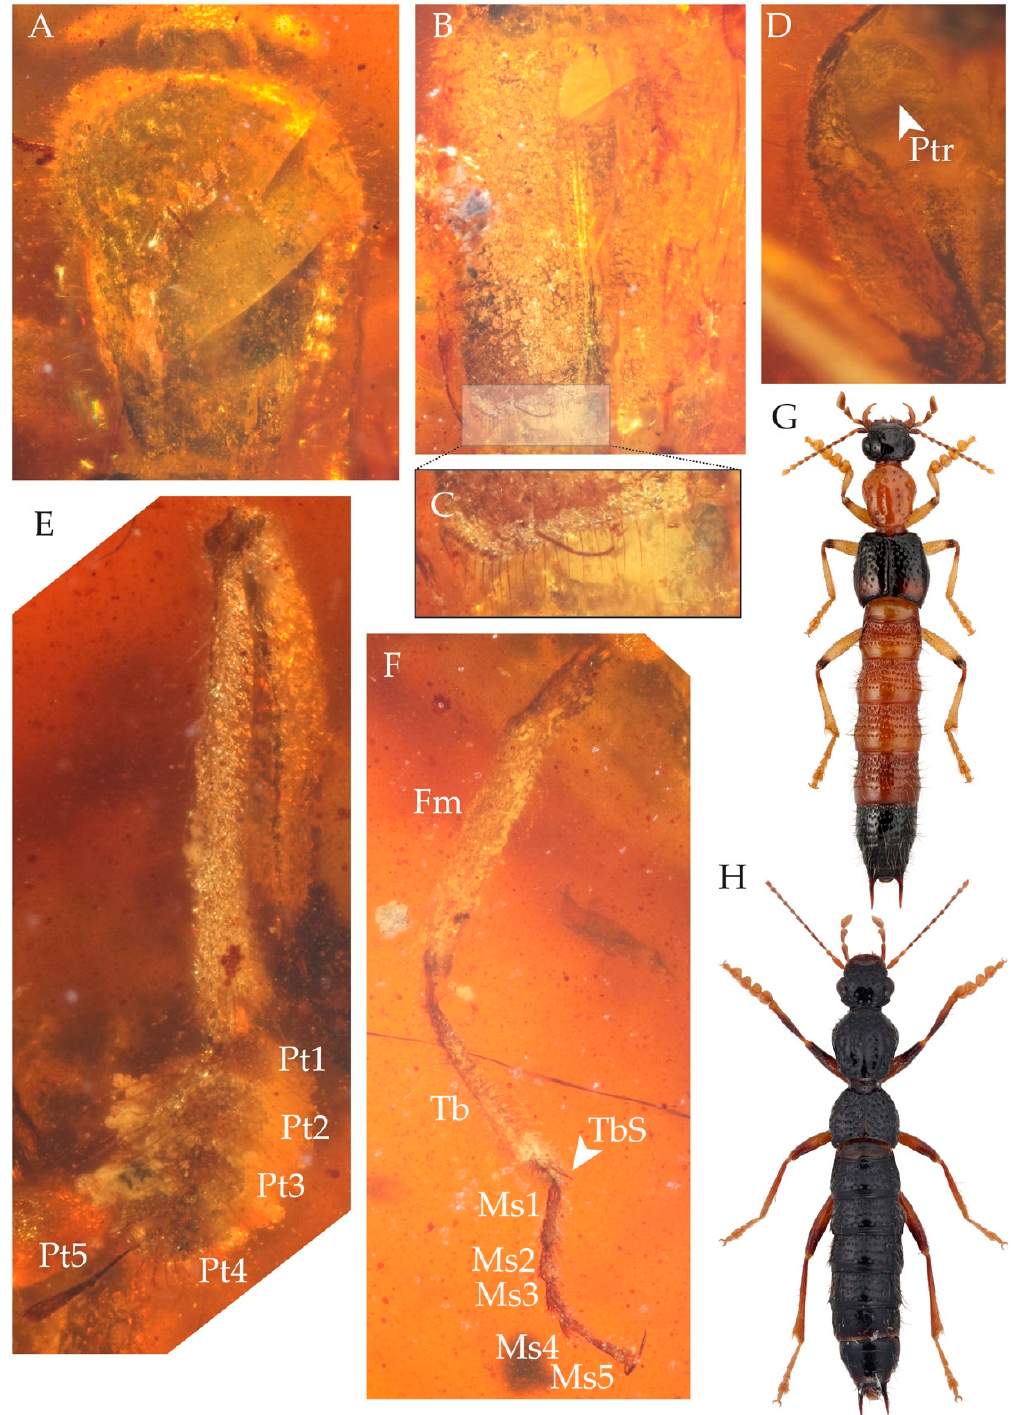
Figure 3. Morphology of Cretoprocirrus trichotos Jenkins Shaw and ˙Zyła gen. et sp. n.: ( A ) pronotum, ( B ) elytra, ( C ) close-up of apical part of left elytron, ( D ) ventral view of left side of prothorax, ( E ) fore leg, ( F ) middle leg, ( G ) Oedichirus lewisius Sharp, 1874, ( H ) Oedichirus sp. Fm = femur, Ms = mesotarsomere, Pt = protarsomere, Ptr = protrochanter, Tb = tibia, TbS = tibial spur. Photo of Oedichirus lewisius from www.zin.ru\Animalia\Coleoptera (K.V. Makarov).